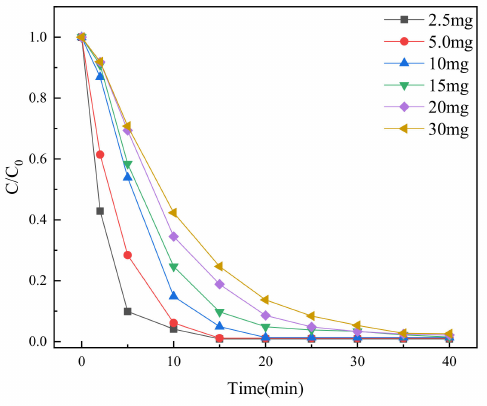
Figure 9. CQP degradation at various initial concentrations. (Experimental conditions: [[CQP] 0 = 10 mg/L, catalyst = 35 mg/L, PMS = 2.0 mM, initial pH = 6.5 ± 0.3, T = 25 ◦